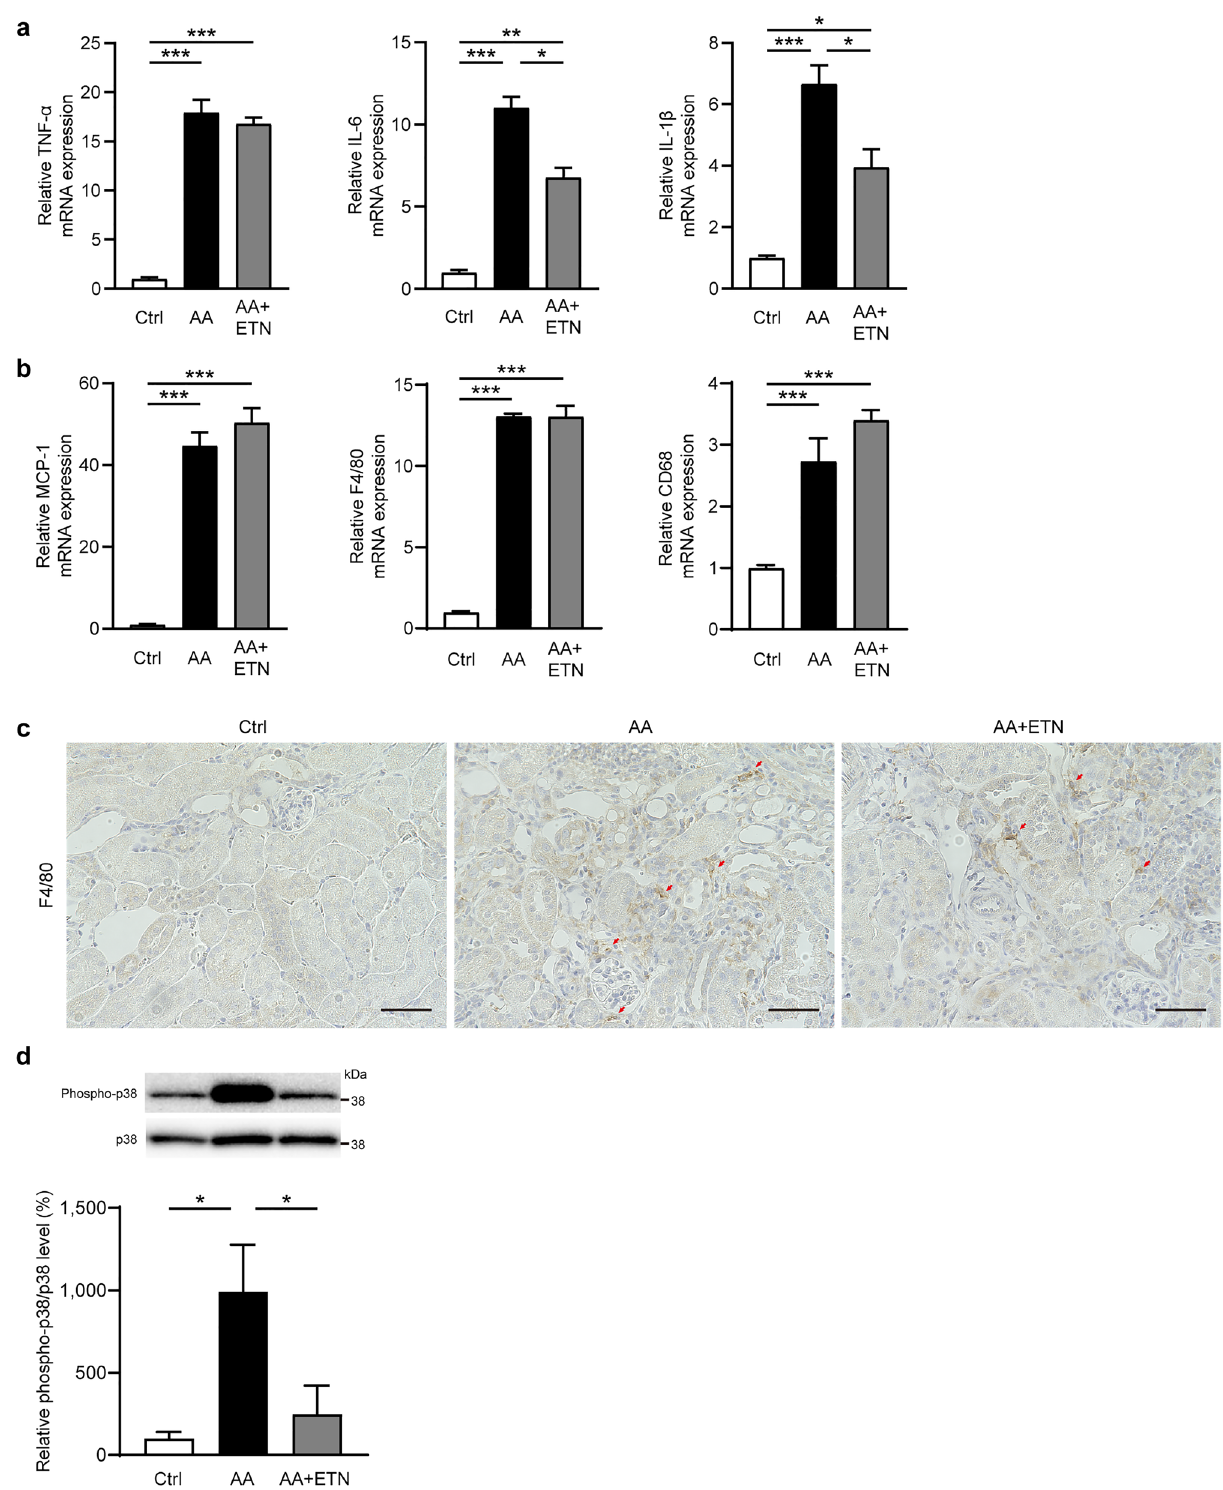
Figure 4. Effect of etanercept on renal inflammation and phosphorylation of p38 MAPK. ( a ) Relative renal mRNA expression of TNF-α, IL-6, and IL-1β ( n = 7–8). ( b ) Relative gene expressions of MCP-1, F4/80, and CD68 ( n = 7–8). ( c ) Representative images of kidneys stained with F4/80 (original magnification, × 400, bar, 50 μm). ( d ) Representative western blots and quantitative analysis of phosphorylated and total p38 MAPK in the kidney ( n = 8). Values are means ± SEM. * P < 0.05, ** P < 0.01, *** P < 0.001. Ctrl, control; AA, aristolochic acid; ETN,